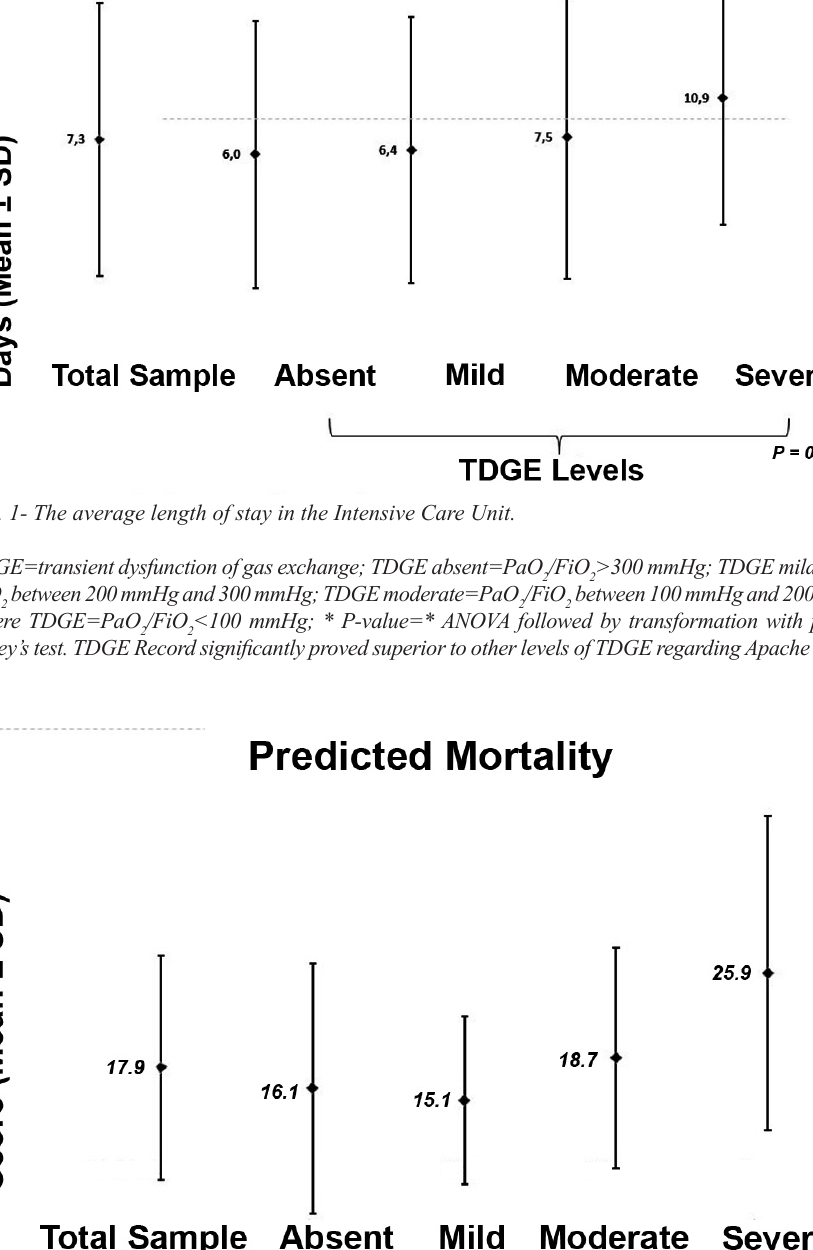
/FiO >300 mmHg; TDGE mild=PaO 2 2 /FiO between 100 mmHg and 200 mmHg; 2 2